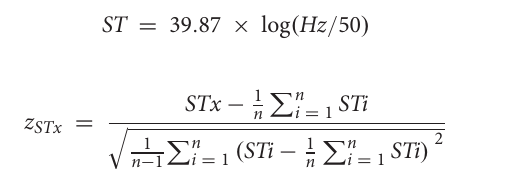
model consisting of all the three terms was the optimal [linear